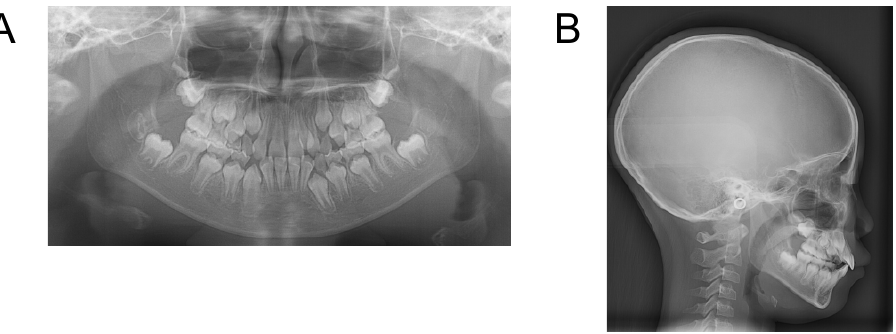
Figure 13. Panoramic radiograph ( A ) and lateral roentgenographic cephalogram ( B ) of Case 3 at initial examination. Table 5. Cephalogram angle measurements of Case 3.